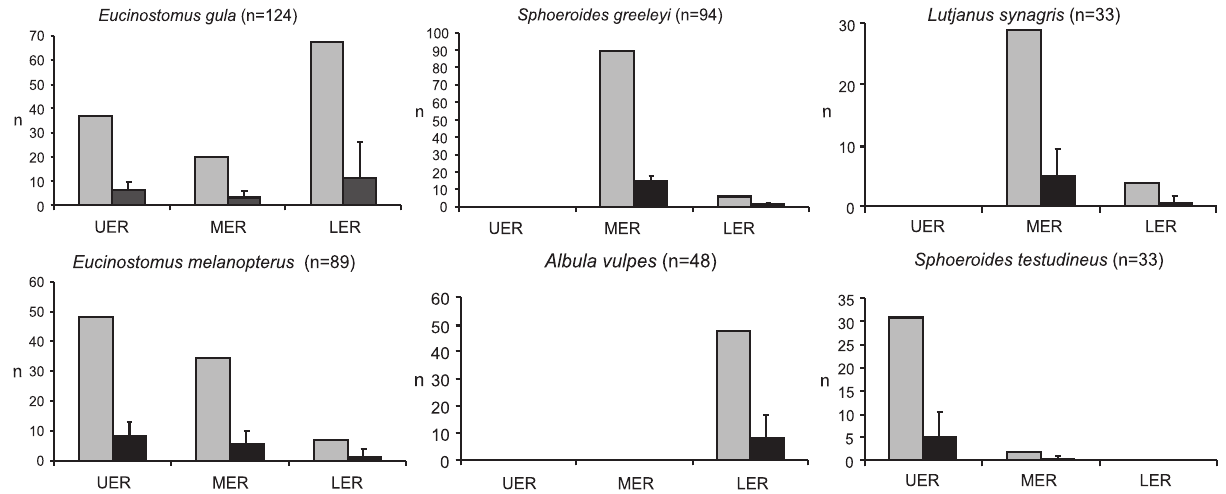
Figure 4. Most abundant species in the upper (UER) and mid (UER) estuarine regions of the Rio Formoso (PE). n: number of individuals; striped column: total number of individuals; black column: average; vertical bar: standard deviation.